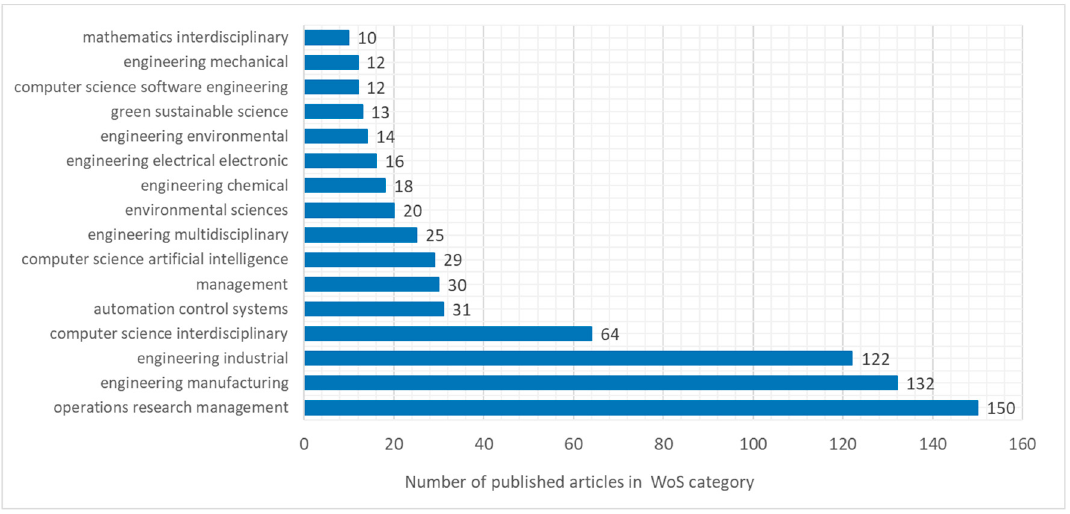
Figure 5. Distribution of papers according to Web of Science categories.